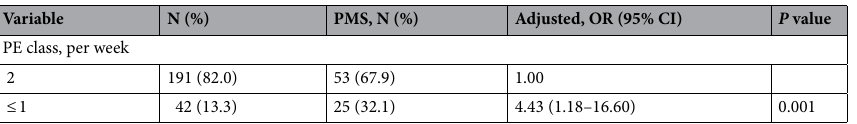
Table 3. Multivariate logistic regression analysis of variables associated with PMS. PMS premenstrual syndrome, OR odds ratio, CI confidence intervals, PE physical education.